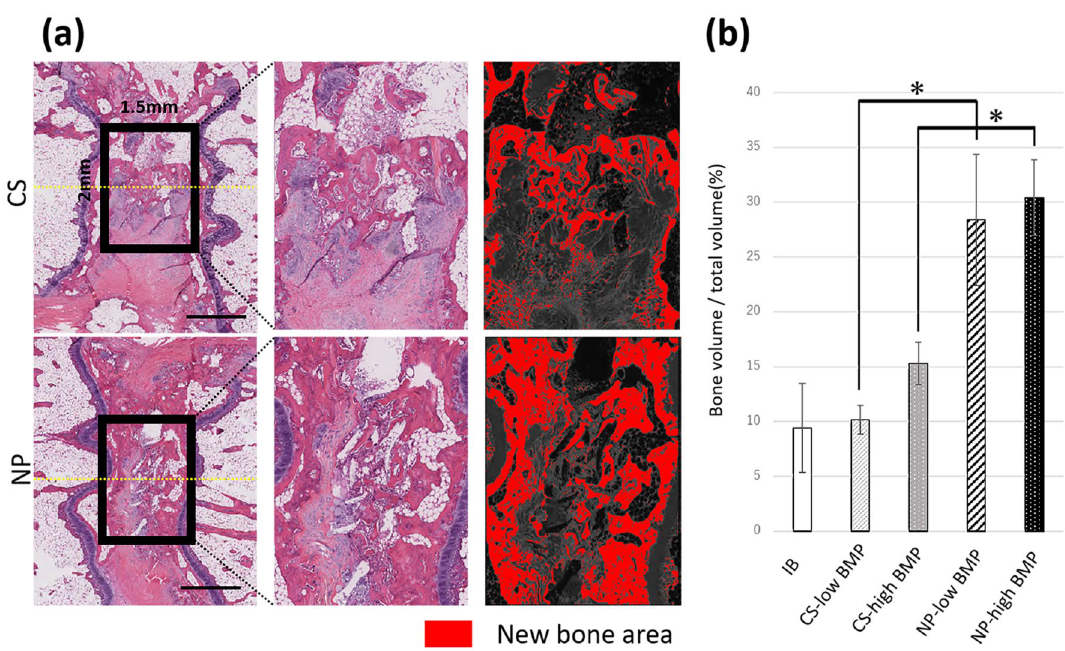
Figure 6. Quantification of the new bone area in the interbody space. ( a ) Comparison of new bone area inside the spinal fusion mass in histological sections. A 1.5 × 2 mm 2 ROI (interbody space) was extracted from the newly formed fusion mass. The new bone area (red) was color-coded using the ImageJ software (version 1.52q, U. S. National Institutes of Health; https:// imagej. nih. gov/ ij/). ( b ) The percentage of the newly formed bone area in the ROI was significantly higher in the NP groups than in the CS groups (n = 8, * p < 0.03) (IB, 9.4%; CS-low BMP group, 10.1%; NP-low BMP group, 28.4%; CS-high group, 15.3%; NP-high group, 30.4%; data represent mean ± SD; * p < 0.03 by Tukey–Kramer